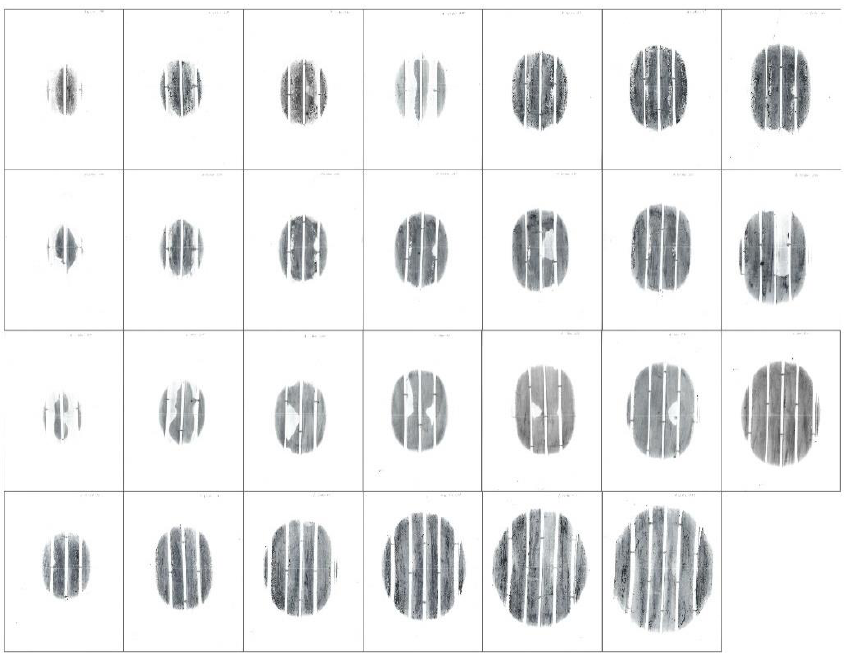
Figure 9. Negatives of wheel-to-surface contact areas for the PZL M28 Skytruck/Bryza aircraft wheel.